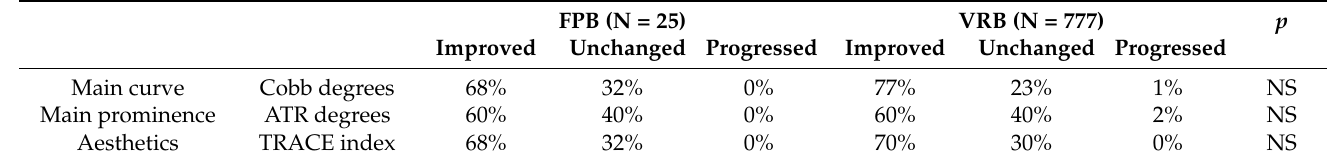
Table 2. Main clinical results in the two studied